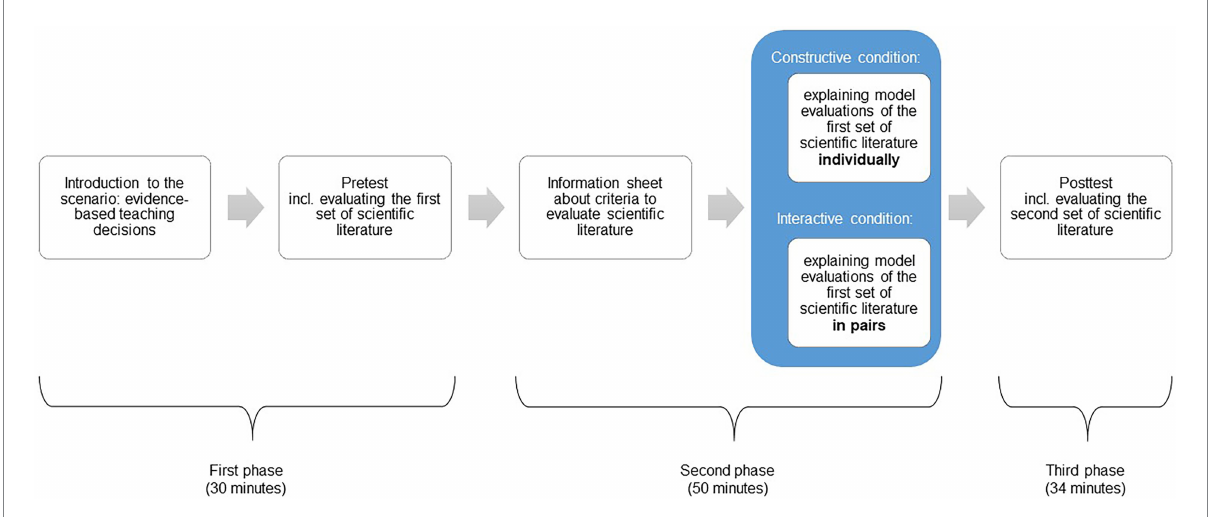
FIGURE 1 Procedure of the experimental study over 2